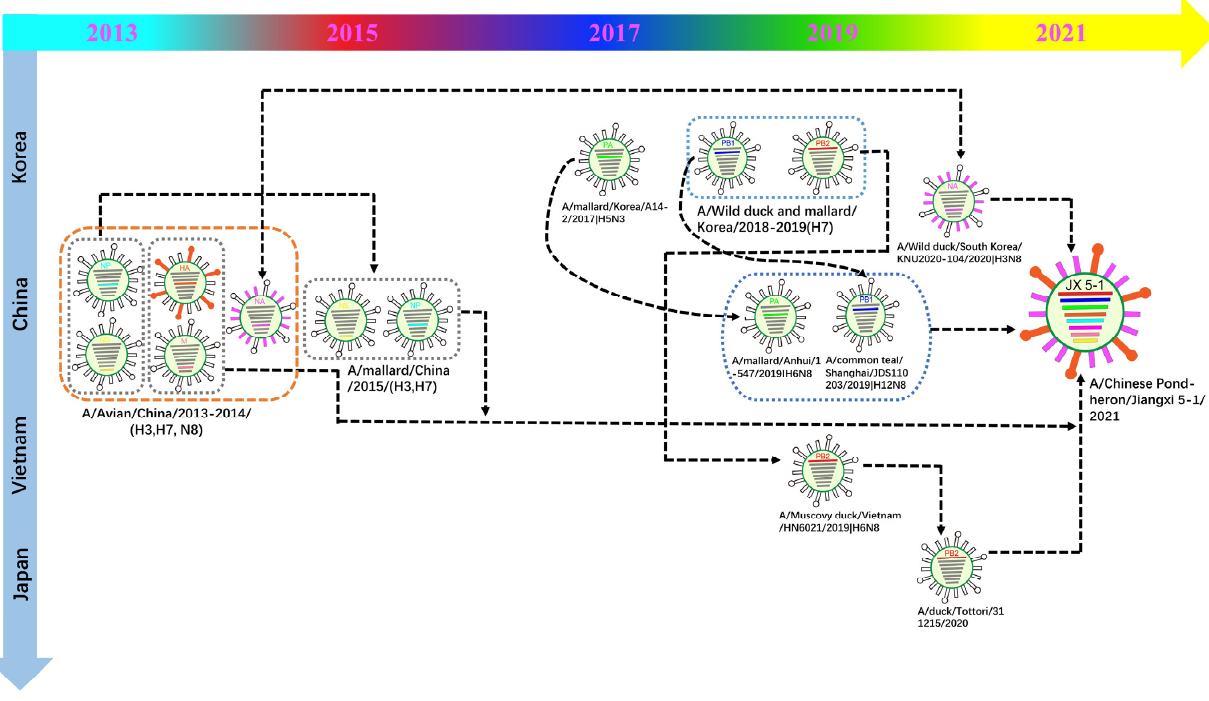
Figure 3. Original reassortment events of the novel avian influenza isolate H3N8 (JX 5-1). The evolutionary rate of eight gene segments of JX 5-1 was estimated using Bayesian analysis (Table S3). Among the eight genes, the evolution rate of the genes NP and PA was significantly faster than that of the other genes. HA gene has the slowest evolutionary rate compared with the other genes. The effective population size of JX 5-1 was estimated based on Bayesian phylodynamics and the Ne value (number of genes that effectively produce the next generation) (Figure 4). The Ne value of HA shows a decreasing trend after 2014 while that of NA plateaus, thus inferring that there was no pandemic outbreak of H3N8 subtype avian influenza virus after 2014. Figure 4. Effective population size of HA and NA. Estimation of effective population size of HA and NA genes of JX 5-1 using the Bayesian SkyGrid model. Panels ( A , B ) represent the HA and NA genes, respectively. 3.3. Molecular Analysis